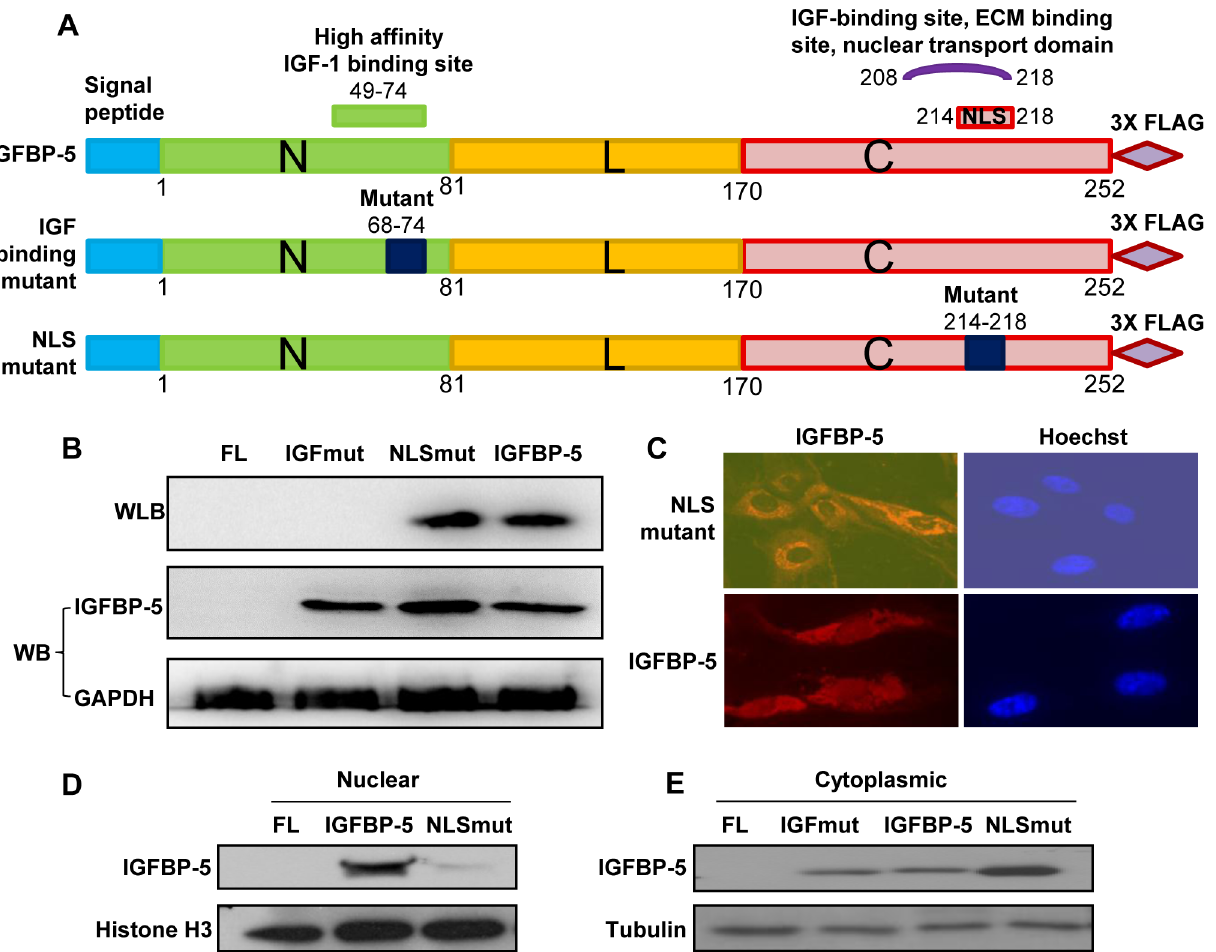
Fig 1. Generation of IGFBP-5 with mutated IGF binding and NLS domains and validation of the loss of function imparted by the mutations. (A) Schematic of wild type, IGF binding site-mutant, and NLS-mutant IGFBP-5 expressing constructs used for the generation of adenoviruses. (B) Confirmation that all three constructs result in IGFBP-5 production by western blotting and validation of the loss of binding to IGF of the IGF-binding site mutant using western ligand blotting. (C) The NLS-mutant IGFBP-5 does not translocate to the nucleus of primary human fibroblasts as detected using immunofluorescence. (D) The NLS-mutant IGFBP-5 is not detected in nuclear extracts of primary human fibroblasts expressing the indicated constructs, but its levels were higher in cytoplasmic fractions as detected following cellular fractionation and